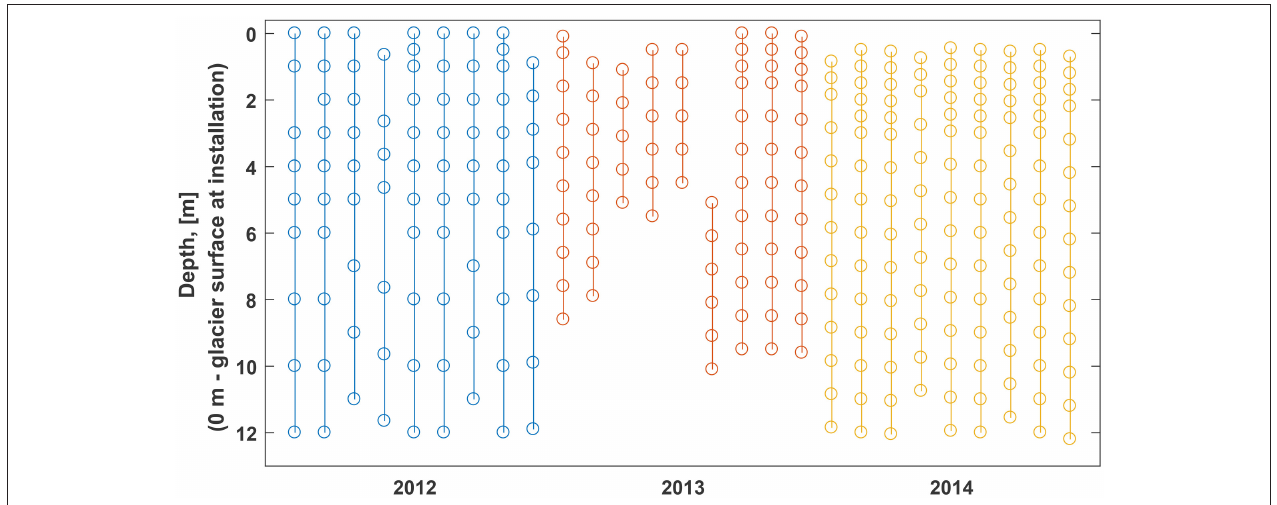
FIGURE 2 | Depths of thermistors installed in April 2012 (blue), April 2013 (red), and April 2014 (yellow) referenced to the glacier surface at